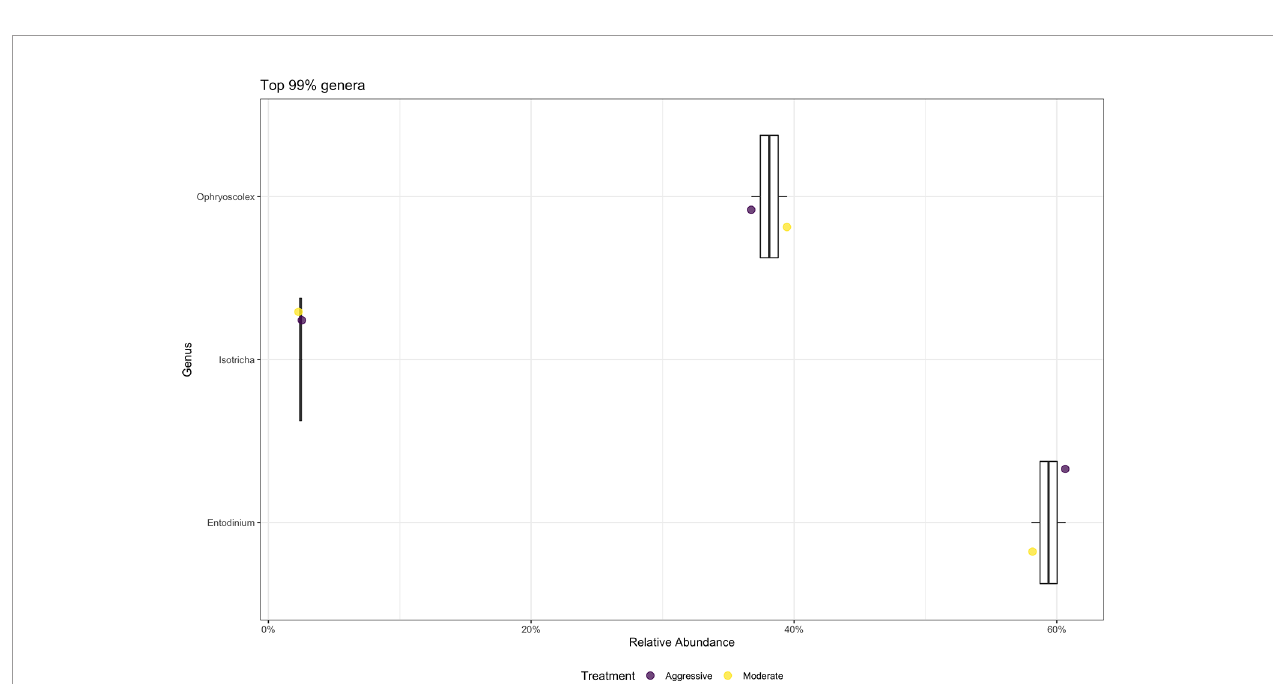
FIGURE 10 | Average relative abundance of the top 99% genus-level protozoal communities classi fi ed in ruminal fl uid between aggressive and moderate implant strategies. Mean relative abundance of protozoal communities associated with the aggressive implant strategy are represented in purple and moderate implant strategy in